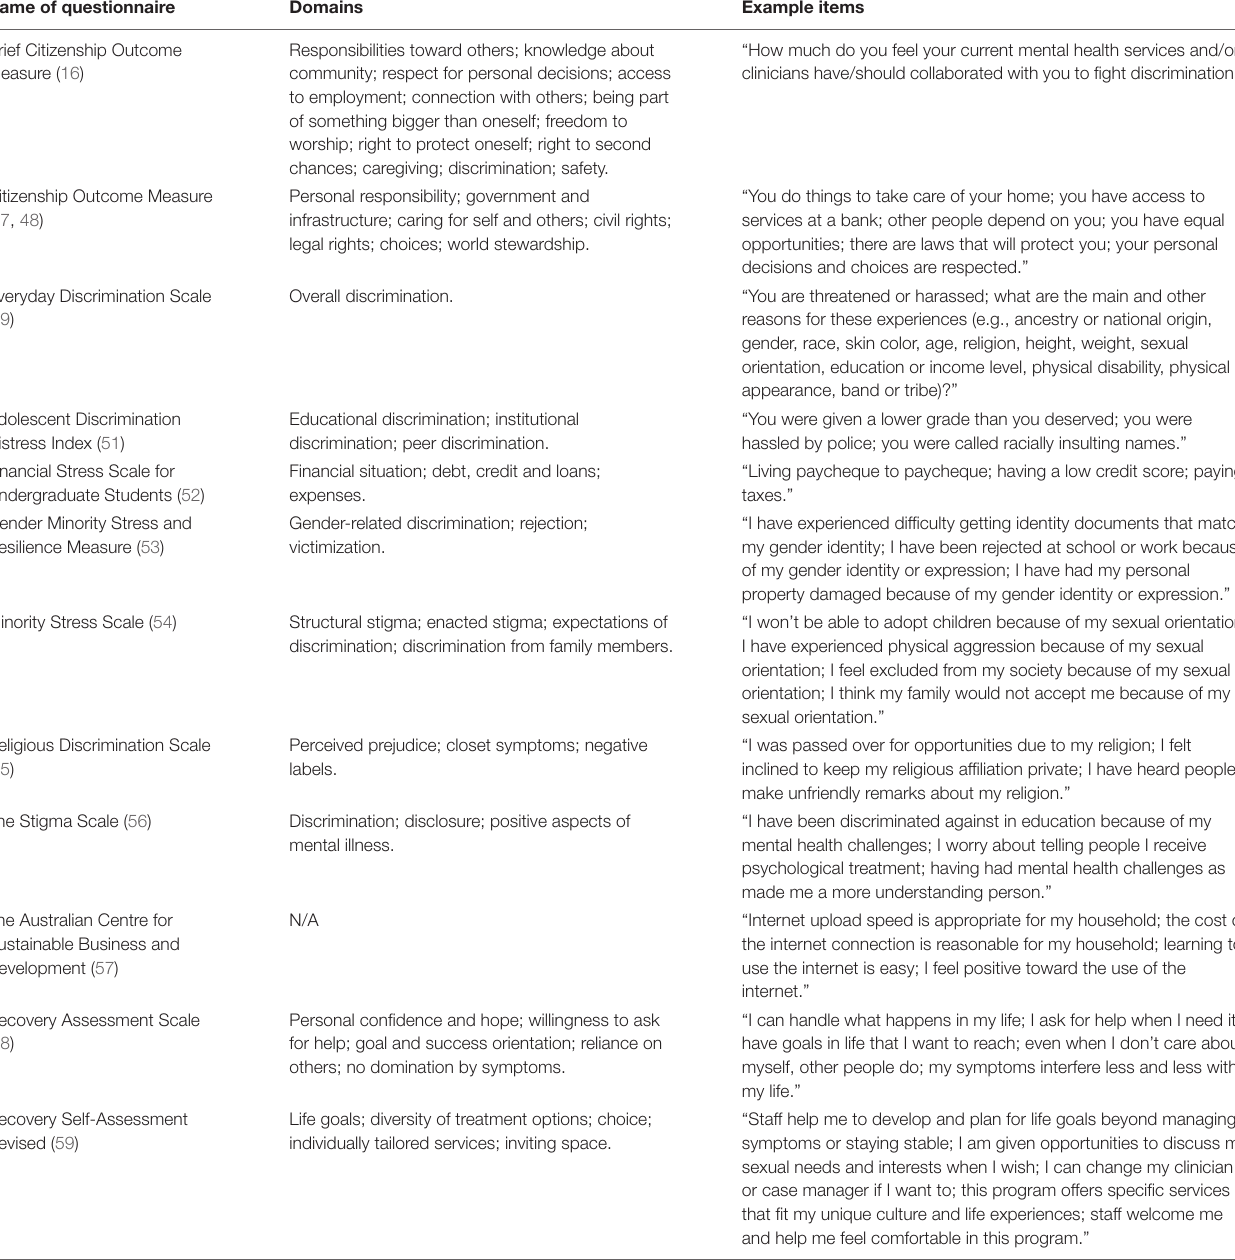
TABLE 1 | Details of included